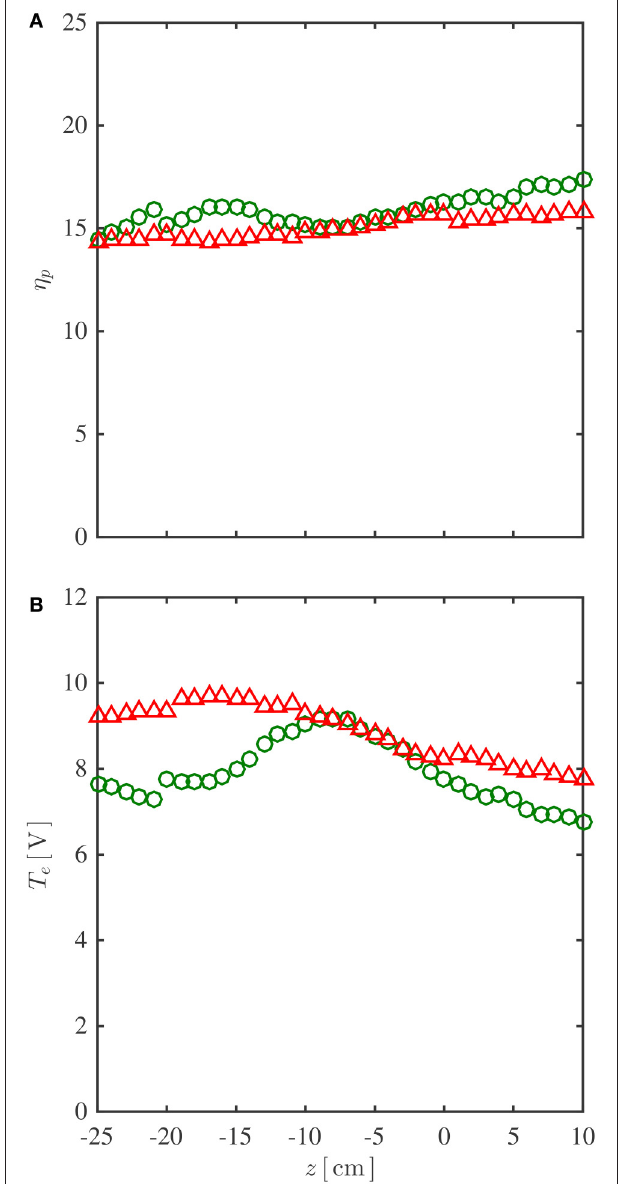
FIGURE 3 | On-axis profiles of (A) dimensionless probe bias η p and (B) electron temperature T e obtained from the RF-compensated Langmuir probe (CP), for high field mode (open circles) and low field mode (open